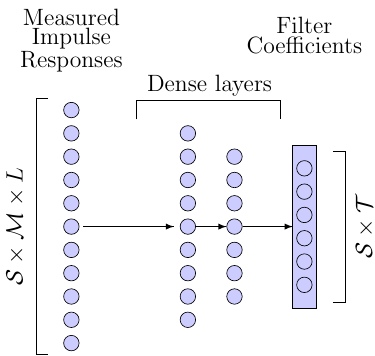
Figure 2. Scheme of the proposed method using an Multilayer Perceptron (MLP). The impulse responses are all concatenated into a vector and fed to the first layer, which must have size